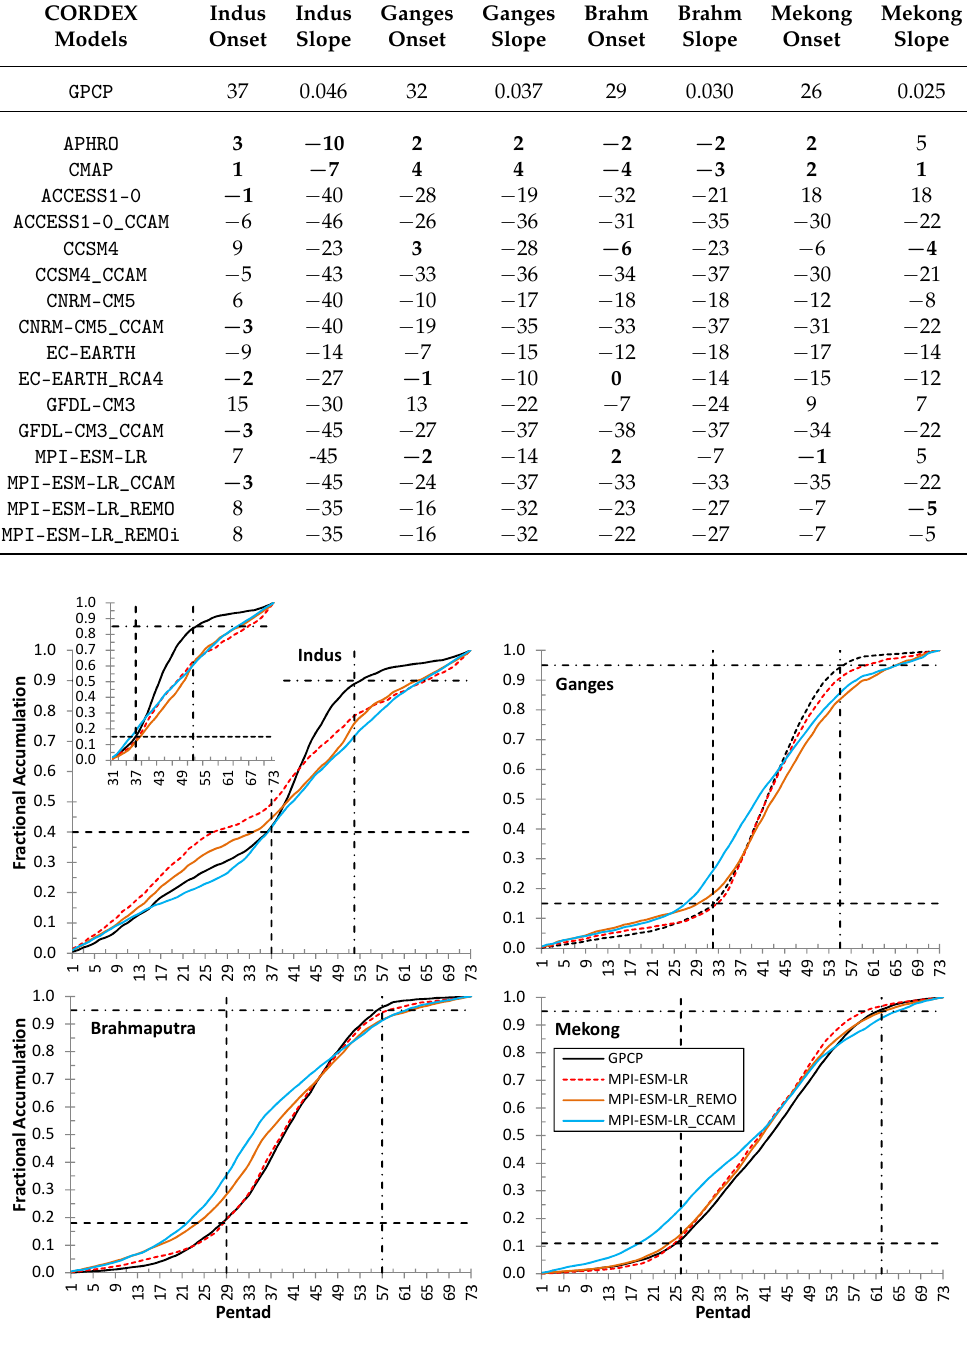
Figure 5. The fractional accumulation of precipitation; comparison of single MPI-ESM-LR CMIP5 model downsclaed with two different RCMs of REMO and CCAM. For Indus, the inset shows the fractional accumulation excluding January to May period of